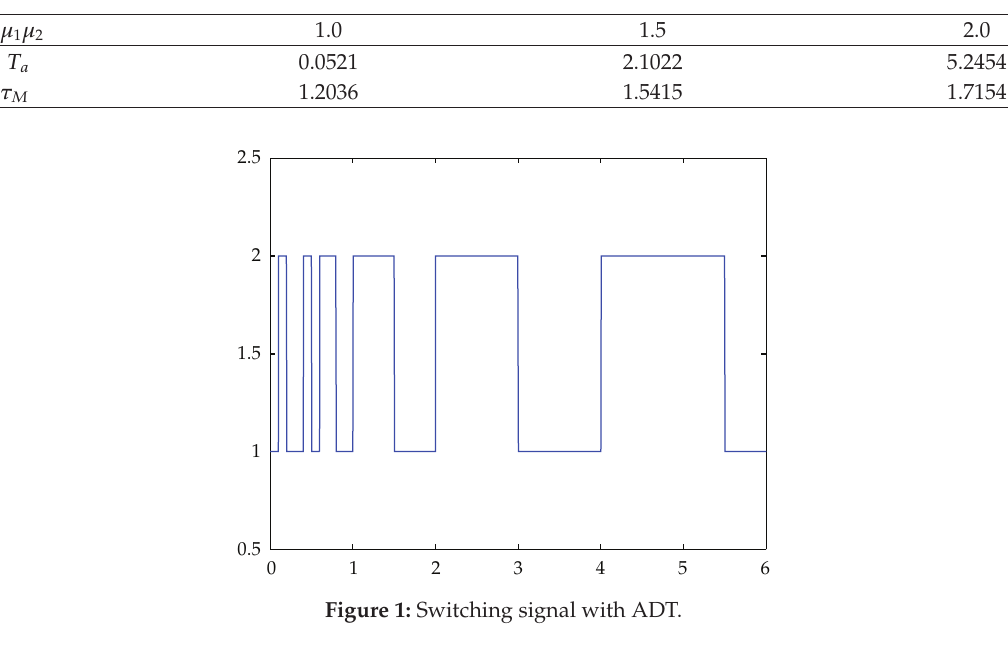
Table 1: Di ff erent T a and τ M for α (cid:8) 0 . 25, β (cid:8) 0 . 2.